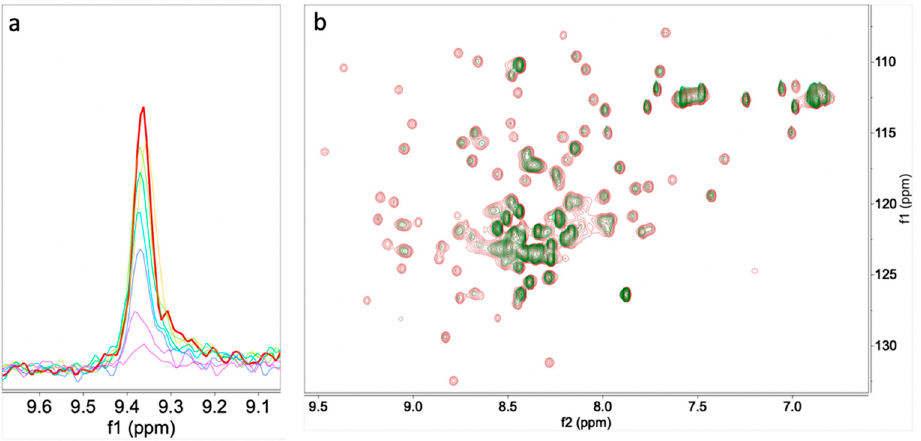
Figure 2. ( a ) Superimposition of trace of peak G 31 of PTN at 0.0 (red), 0.2, 0.4, 0.6, 0.8, 1.0, 1.5, and 2.0 (purple) equivalent of 3 . ( b ) Superimposition of 15 N HSQC spectra of PTN at 0.0 (red), and 1.5 (green), added equivalents of 3 .